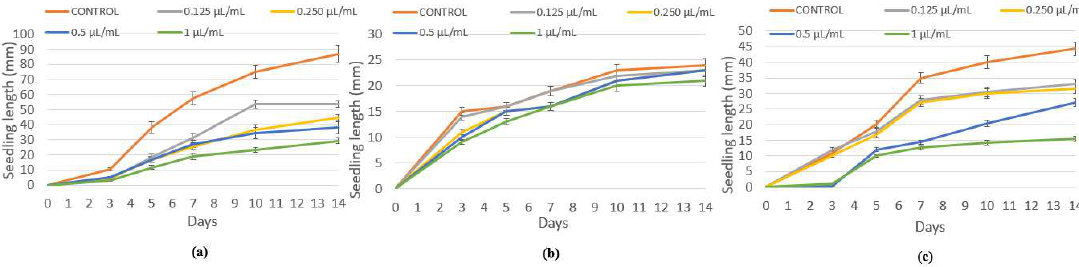
Figure 2. ( a ) L. multiflorum , ( b ) P. oleracea , and ( c ) E. crus-galli seedling growth. Control and treated with anise essential oil at 0.125, 0.25, 0.50, and 1 µL/mL.